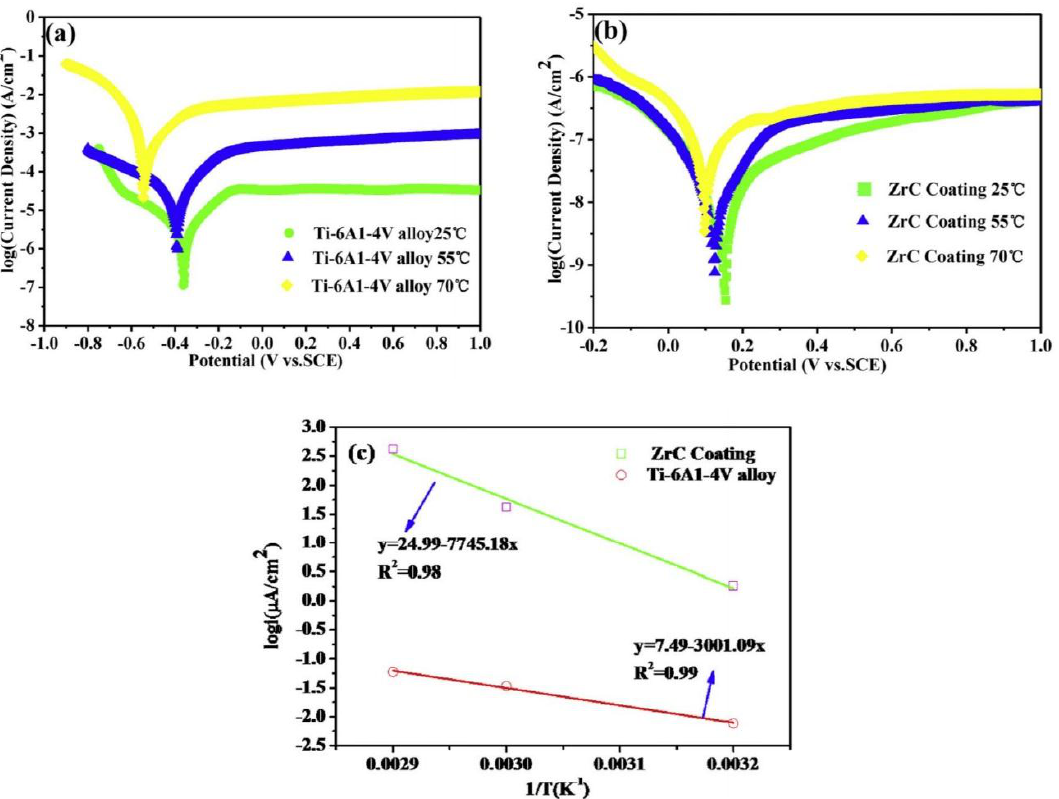
Figure 7. Potentiodynamic cure ( a ) bare Ti-6Al-4V, ( b ) ZrC sample, ( c ) Arrhenius plot for Ti-6Al-4V and ZrC sample [70].